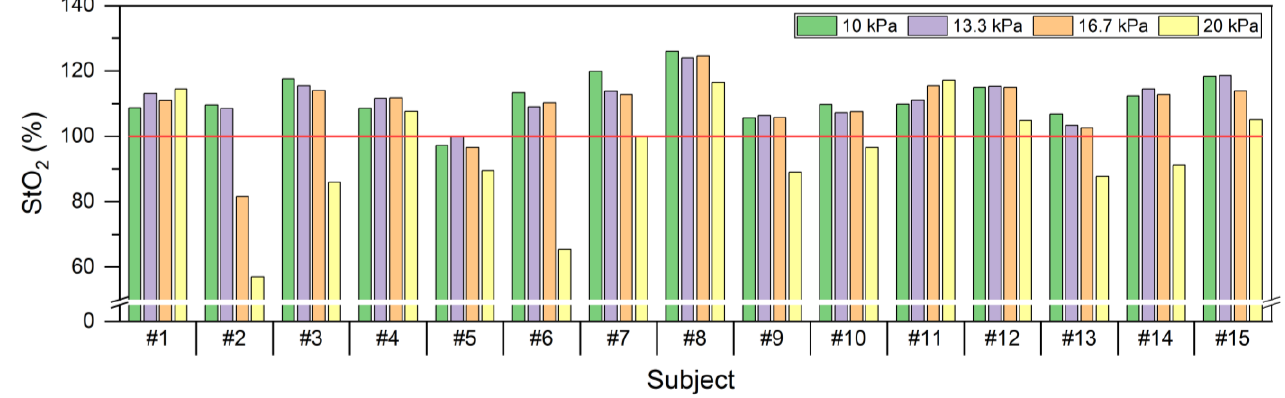
Figure 4. StO 2 according to cuff pressures per subject in 15